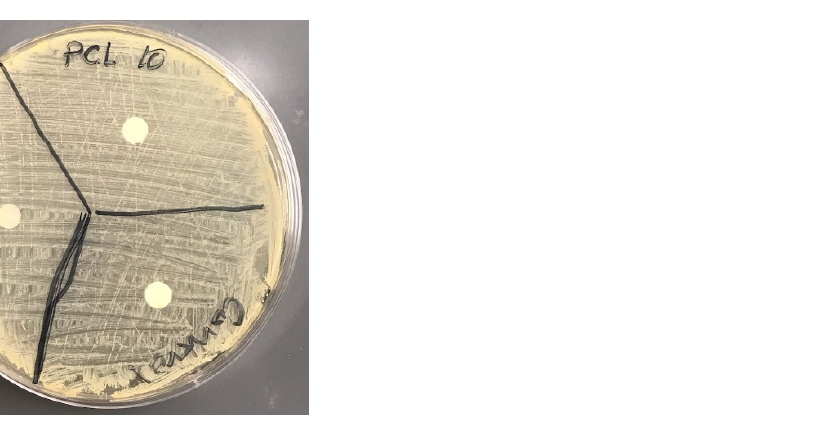
Figure 15. Inhibition zone experiment on a control, PCL-3, and PCL-10 disc in a TSA agar plate.